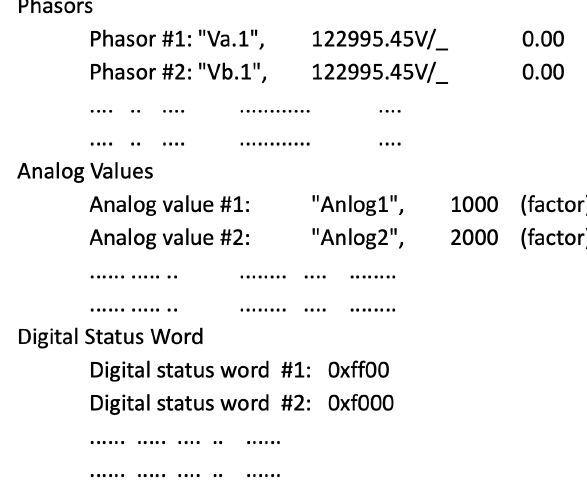
Figure 24. The structure of Phasor Measurement Units (PMU) messages.